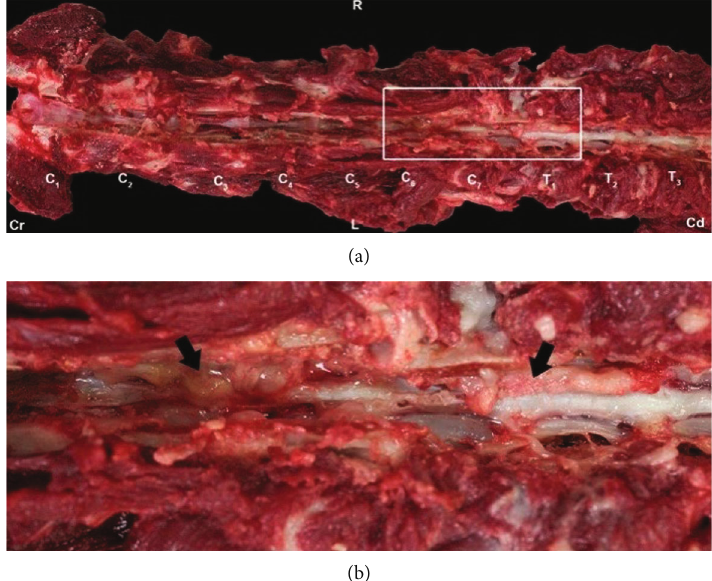
Figure 2: Gross pathology dorsal view of the vertebral column. The dorsal vertebral processes and spinal cord removed, exposing the ventral aspect of the intervertebral canal. (a) Vertebral column from C1 to T3. (b) Vertebral column from C6 to T1, inset of Figure 1(a). Within the right ventrolateral aspect of the intervertebral canal from C6 to T1 are aggregates of pale tan to pink, soft, gelatinous exudate (arrowheads). Exudate extended into the right intervertebral foramina between C5-C6, C6-C7, and C7-T1. Cr: cranial aspect; Cd: caudal aspect; R: right; L: left; C1-T3: approximate locations of each of the cervical and thoracic